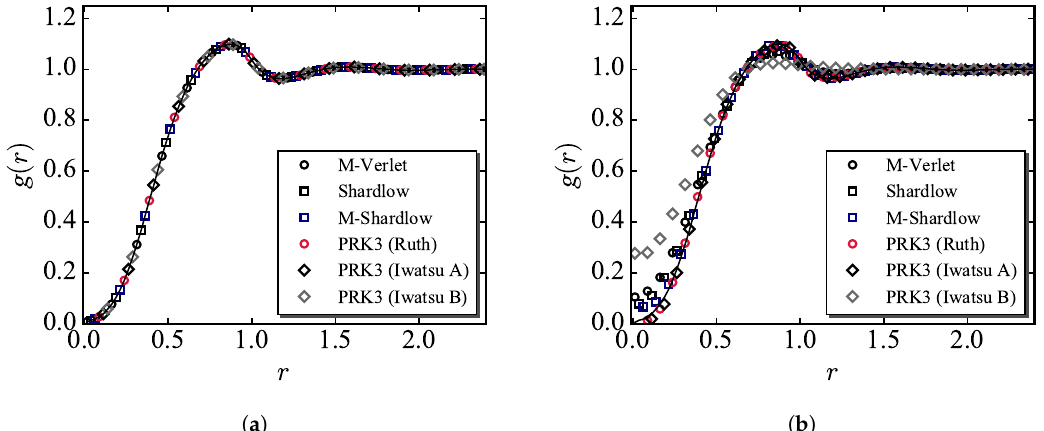
Figure 3. Radial distribution function on different time integration schemes for ( a ) ∆ t = 0.01 and ( b ) ∆ t = 0.1. The solid line is the result of the M-Verlet scheme for ∆ t =